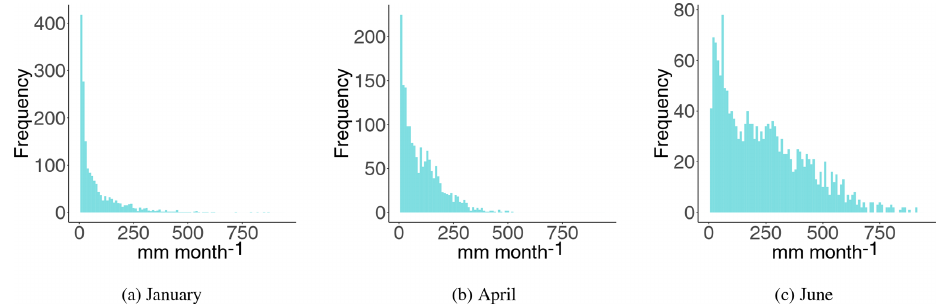
Figure 4. Monthly runoff data (1996–2005) from 180 catchments in Norway for January, April and June. These are used to evaluate the framework’s ability to fill in missing values for hydrological variables and/or study areas that are driven by more unstable weather patterns.